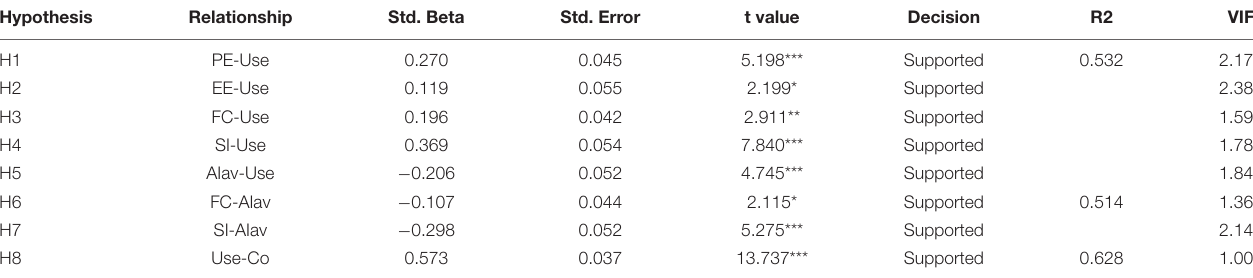
TABLE 5 | Result of path analysis first order.